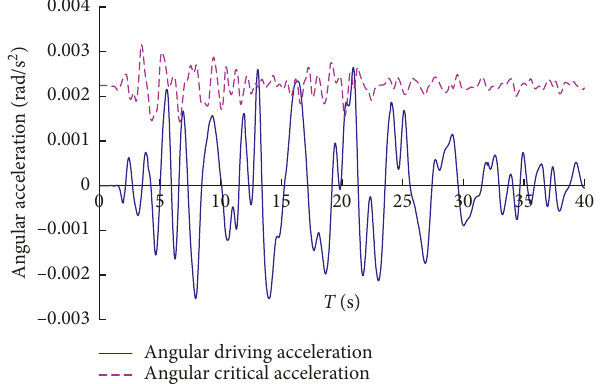
Figure 12: Time history angular driving acceleration and critical acceleration of slip surface in downstream dam slope.